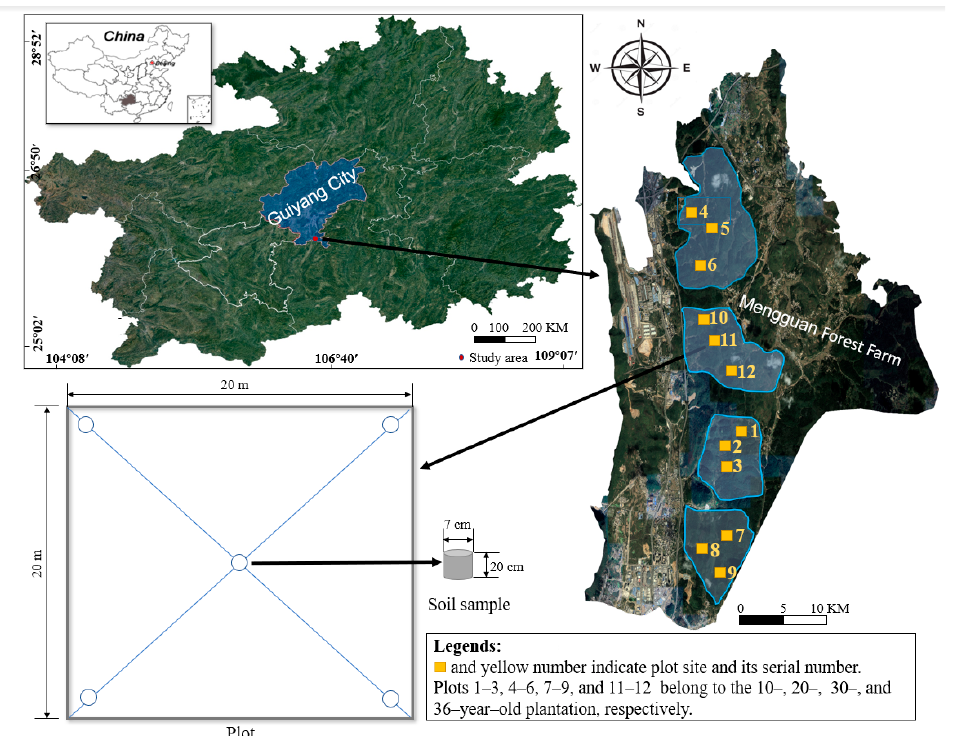
Figure 1. Location of Mengguan Forest Farm study area in Guizhou, China and soil sample distribution in each sample plot.